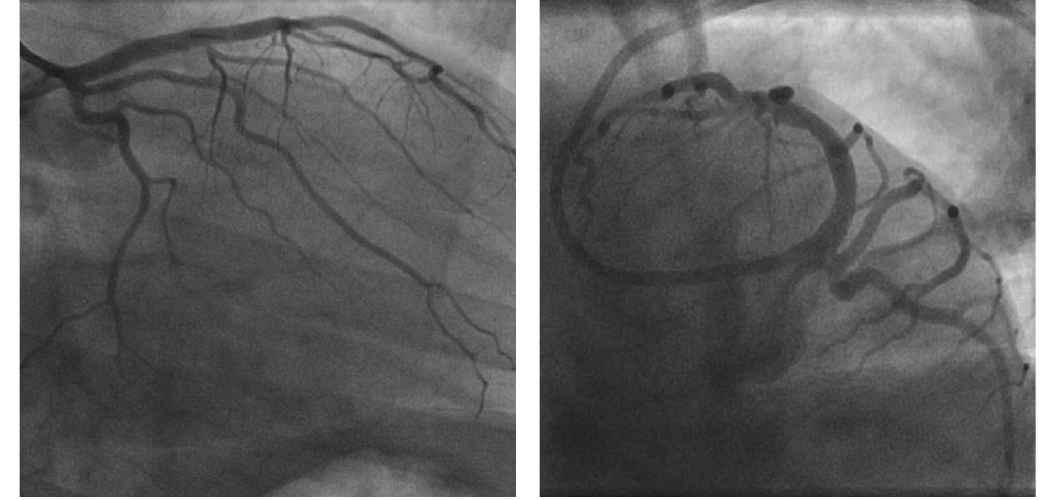
Figure 2: Complete resolution of thrombus in the same projection six weeks